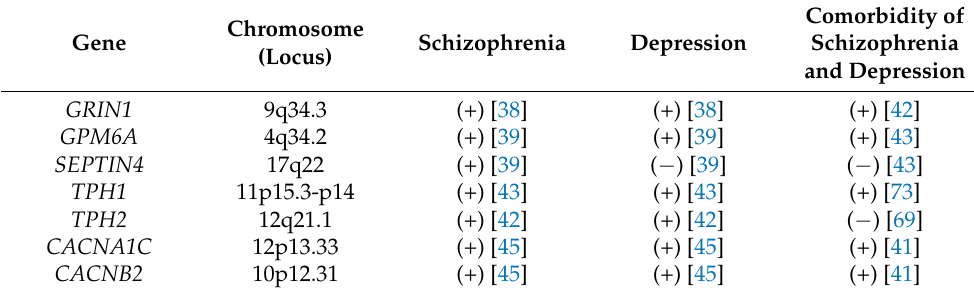
Table 3. Candidate genes predisposing to comorbidity of schizophrenia and depression. Chromosome Gene (Locus)